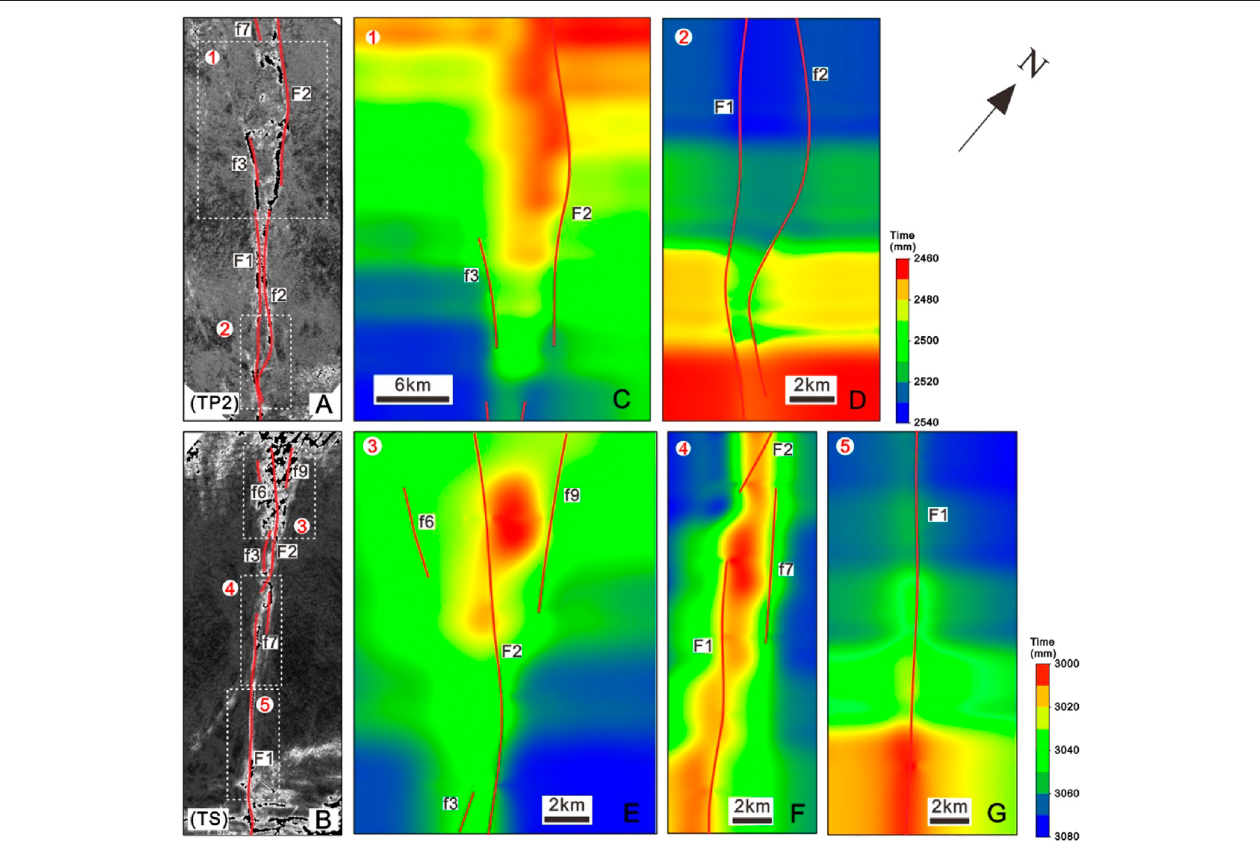
FIGURE 10 | Timestructure maps (milliseconds) of the TP2 (C,D) and TS (E – G) seismic surfaces covering the south No.15 fault zone, showing the structuralrelief alongthesouthNo.15faultzoneatvariousdepths[see (A) and (B) forthelocationsof (C – G) ],ThedepthdatausedinthemapcamefromTSandTP2interpretationdata of 3D seismic data in the study